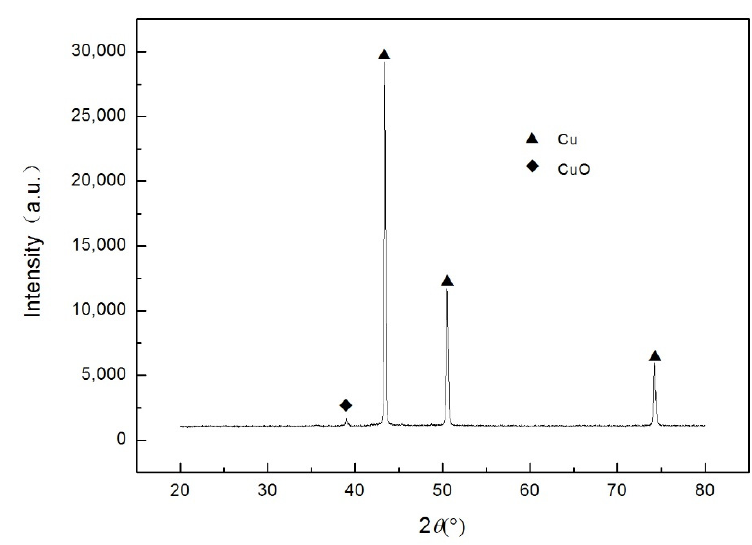
Figure 1. The XRD pattern of partially oxidized copper powder sample.